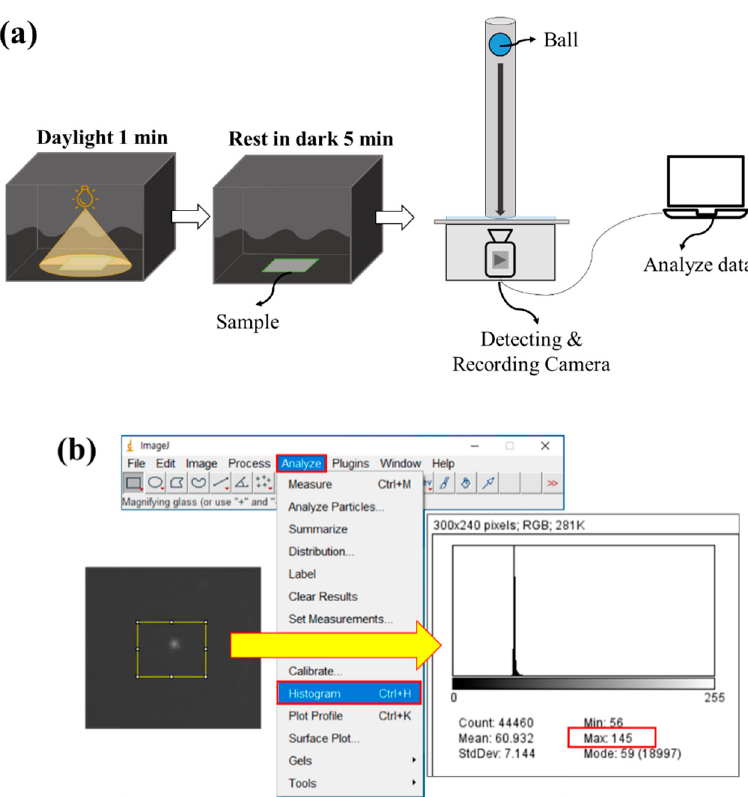
Figure 1. Light emission investigation of the mechanoluminescence (ML) / poly(vinylidene fluoride) (PVDF) composite. ( a ) Test setup for measurement of mechanoluminescence of ML composite fabrics; ( b ) image processing after drop ball test using ImageJ.